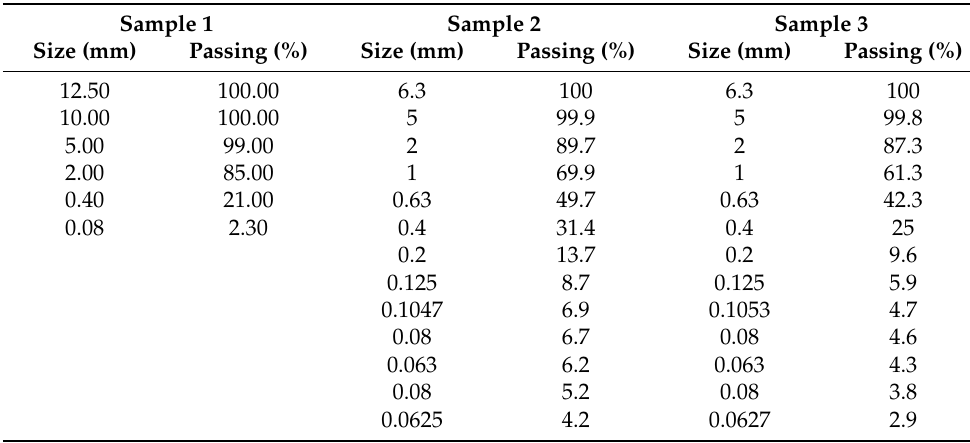
Table 1. Gradings of the sandy granular